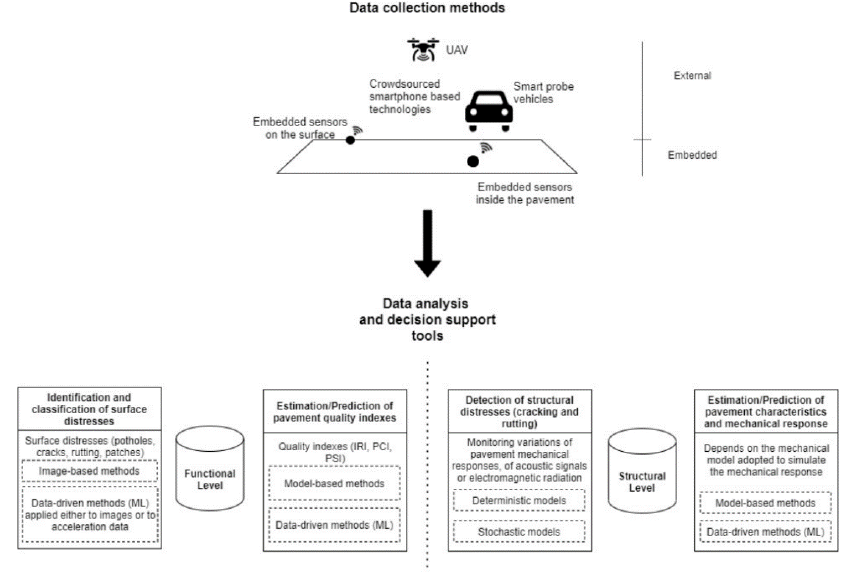
Figure 1. Decision support system for smart pavement [1].